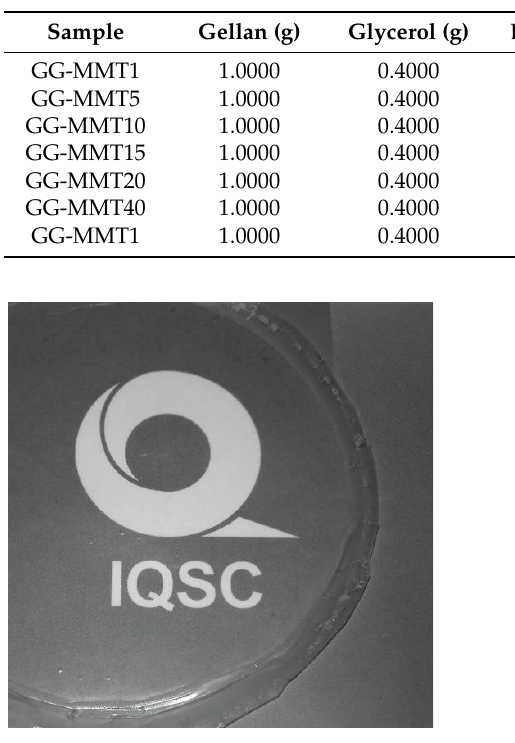
Table 10. Compositions of GGLA-MMT-based NPEs.